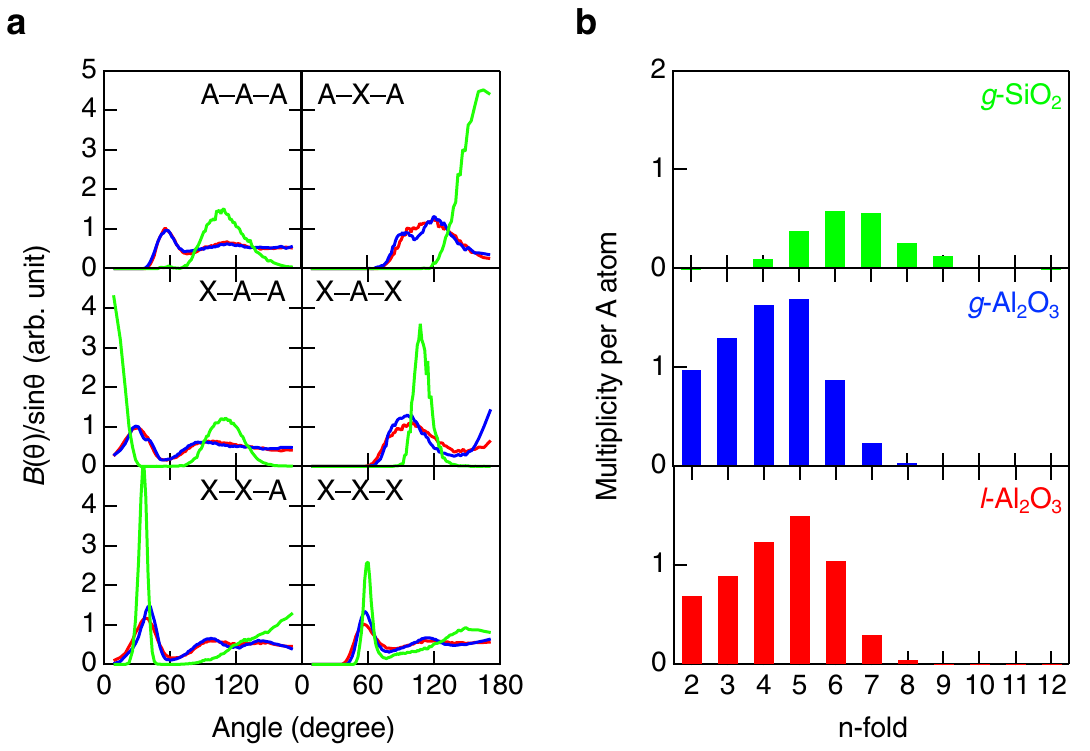
Figure 5. ( a ) Bond angle distributions for g -Al 2 O 3 , l -Al 2 O 3 , and g -SiO 2 . ( b ) Primitive ring size distributions for g -Al